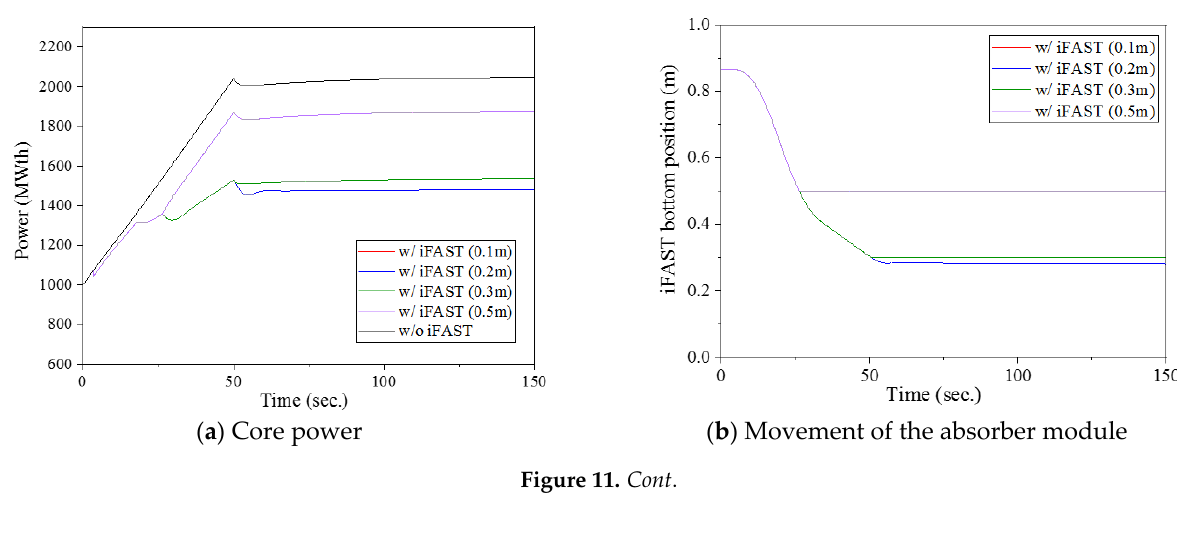
Figure 10. Unprotected transient over power (1$/50 s) with constant temperature drop in IHX and 1$ maximum iFAST worth.